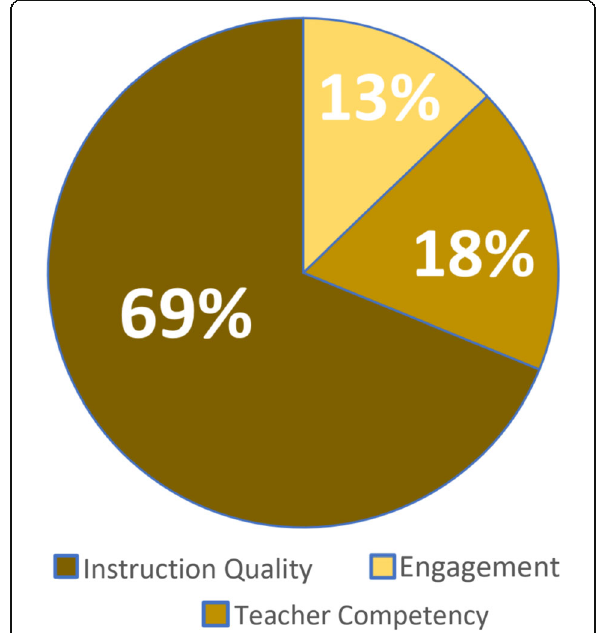
Fig. 16 Tertiary breakdown of reasoning for learner